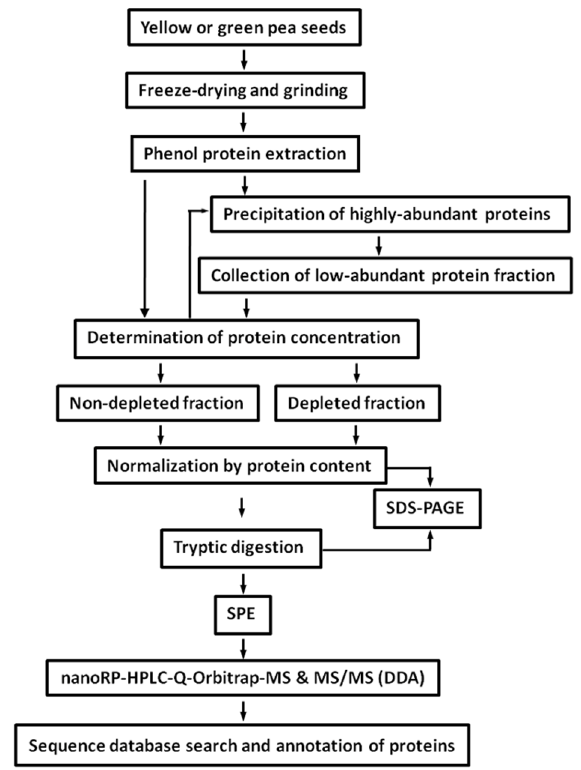
Figure 2. Experimental workflow, employed for characterization of the pea seed proteome.